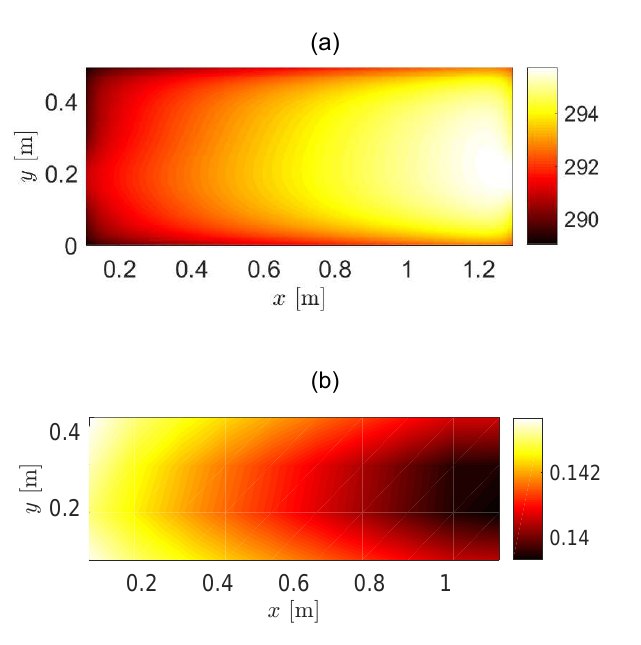
Figure 7. Spatial distribution of ( a ) the cell temperature, T c , and of ( b ) the electrical performance, η , for ˙ v = 1000 L/h.